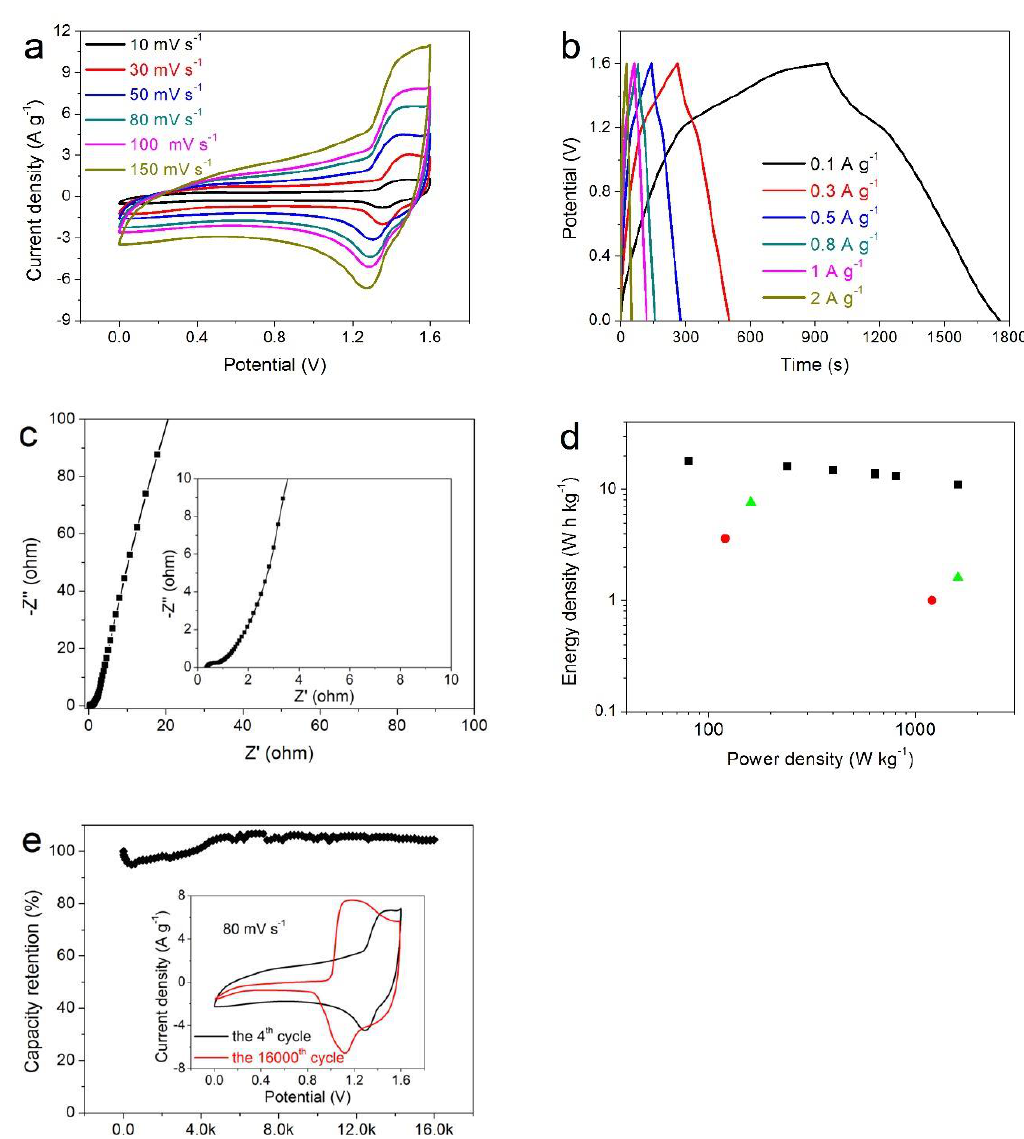
Figure 6. The electrochemical performances of LSNO //activated carbon (AC) hybrid supercapaci- tor device with 6 KOH aqueous solution as electrolyte: ( a ) CV curves; ( b ) GCD curves; ( c ) Nyquist plots; ( d ) Ragone plot ((circle) [41], (triangle) [42], (square) This work), and ( e ) Cycling performance of the LSNO//AC hybrid supercapacitor device.